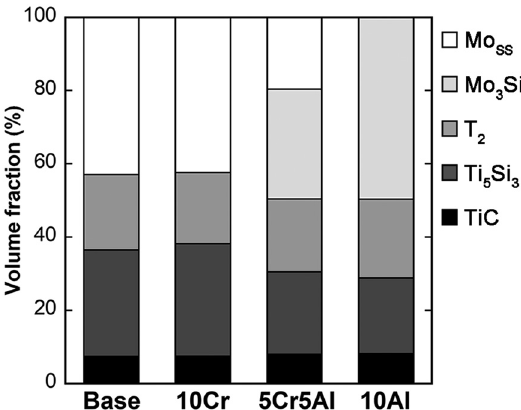
Figure 2: Volume fractions of constituent phases of the heat - treated alloys.